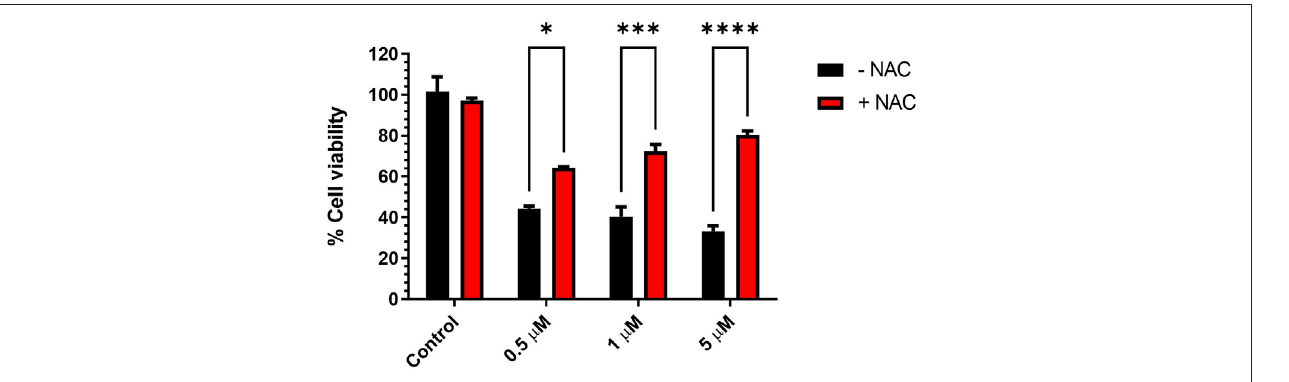
FIGURE10| EffectofantioxidantpretreatmentonviabilityofHCT116treatedwithKIM-161.CellswerepretreatedwithNAC(5 mM)for1 h,followedbyKIM-161 at concentrations 0.5, 1.0, and 5.0 µM for 48 h. Cell viability was expressed as a percentage of vehicle control and was measured by the MTT assay (average of two independent experiments). Statistical signi fi cance was determined by two-way ANOVA using Š ídák ’ s multiple comparisons test. * (cid:1) p < 0.05; *** (cid:1) p ≤ 0.001; **** (cid:1) p < 0.0001.